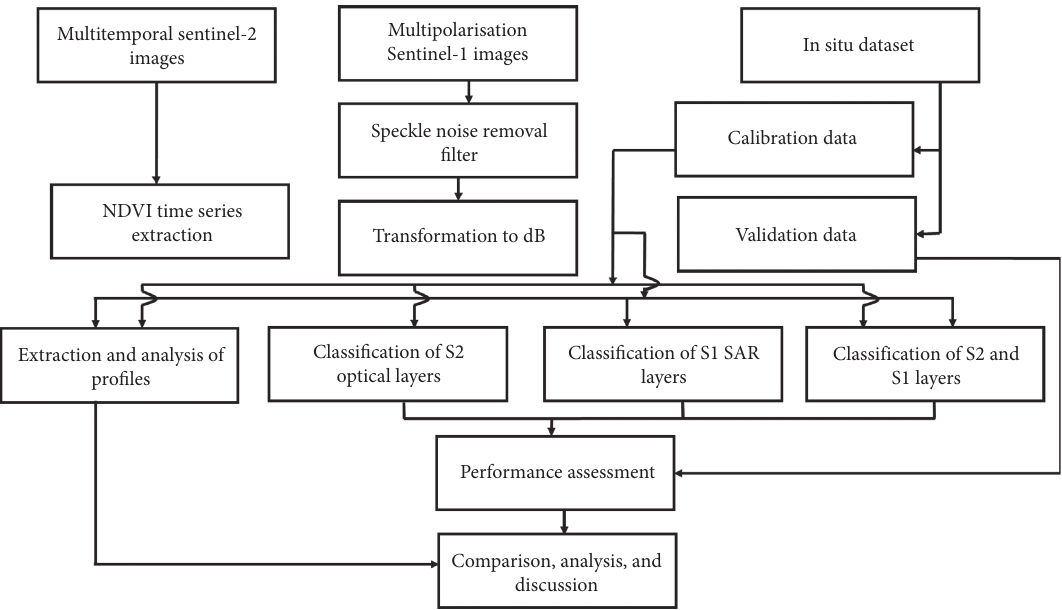
Figure 5: Methodological approach applied in the study.